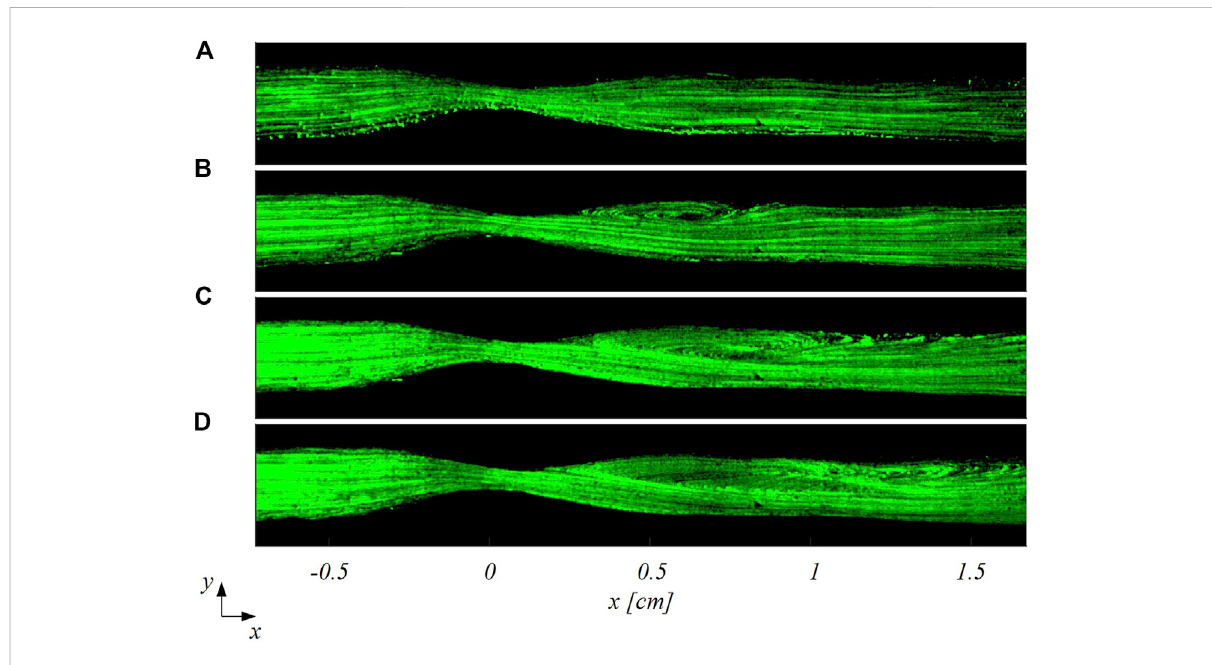
FIGURE 6 Particle trajectories-based visualization of the fl ow patternsin the stenosed LAD at four different in fl ow Reynolds numbers: (A) Re inflow = 21; (B) Re inflow = 64; (C) Re inflow = 107; (D) Re inflow = 171.